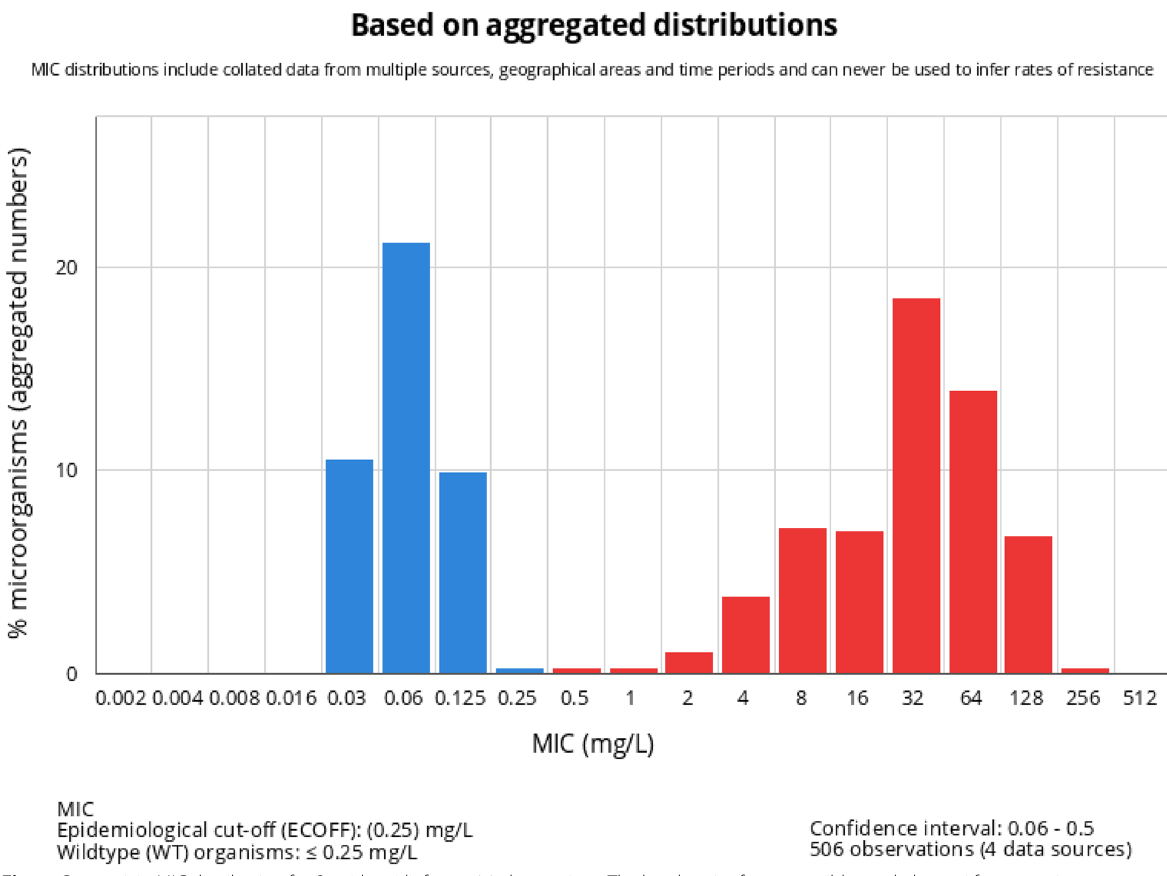
Fig. 4 Gentamicin MIC distribution for S. epidermidis from 506 observations. The break‑point for susceptible staphylococci for systemic administration of gentamicin is 2 mg/L. A potential break‑point for local gentamicin delivery, based on the data about the elution from ALBC and ≤ in vitro data (see text), could be > 32 mg/L (source of the figure: https:// mic. eucast. org, data August 6th,